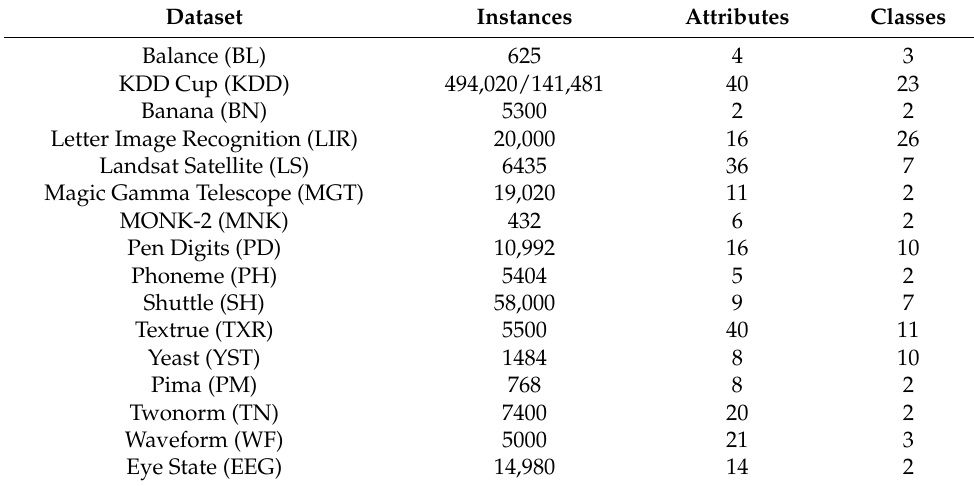
Table 1. Datasets